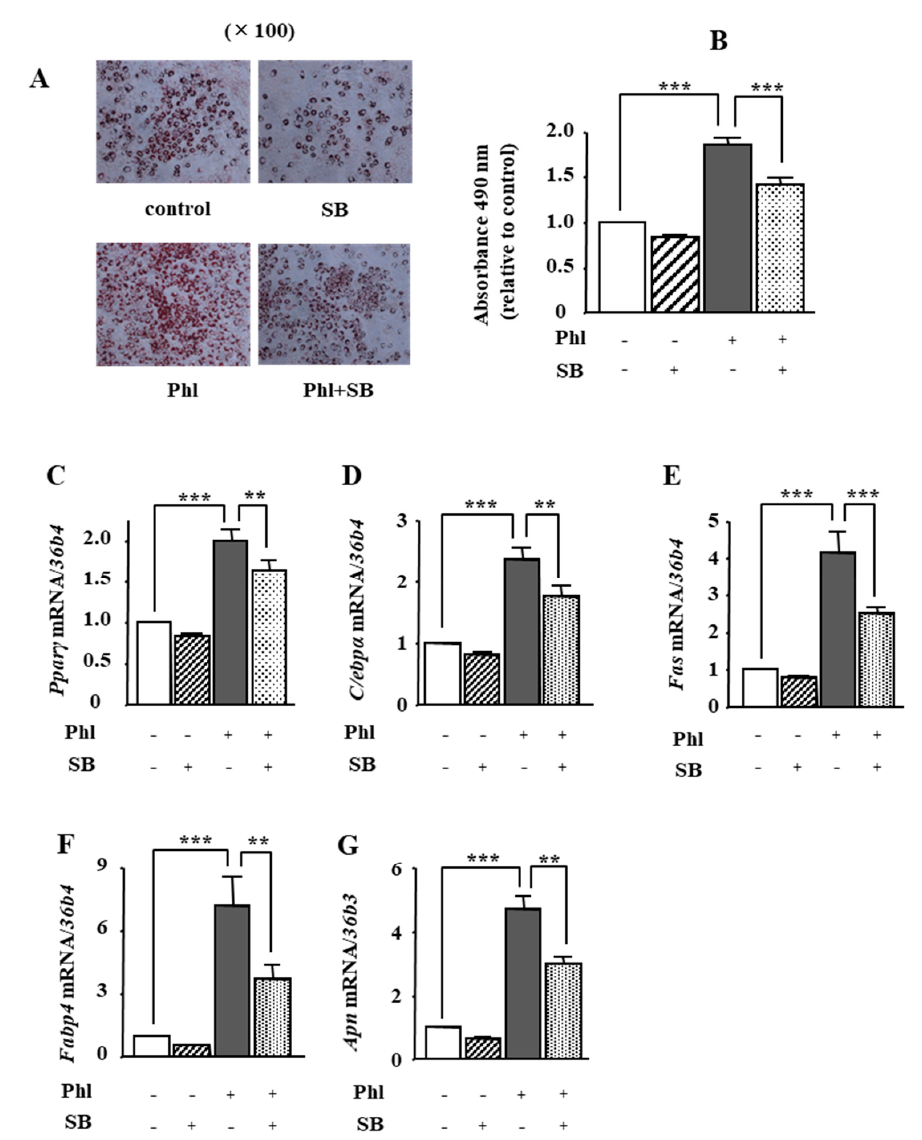
Figure 6. The effects of the p38 MAPK inhibitor SB203580 on phloretin-induced adipogenesis in ST2 cells. ( A , B ) After reaching confluency, ST2 cells were incubated in adipogenic medium with phloretin (50 µM) and/or SB203580, a p38 MAPK inhibitor (0, 5, and 10 µM) for 5 days. Thereafter, oil red O experiments. The quantification results are expressed as mean ± SE ( n = 6); *** p < 0.001. ( C – G ) After reaching confluency, the cells were incubated in adipogenic medium with SB203580 (0, 5, and 10 µ M) for 4 days. The mRNA expression of adipogenic differentiation markers ( Ppar γ , C/ebp α , Fas , Fabp4